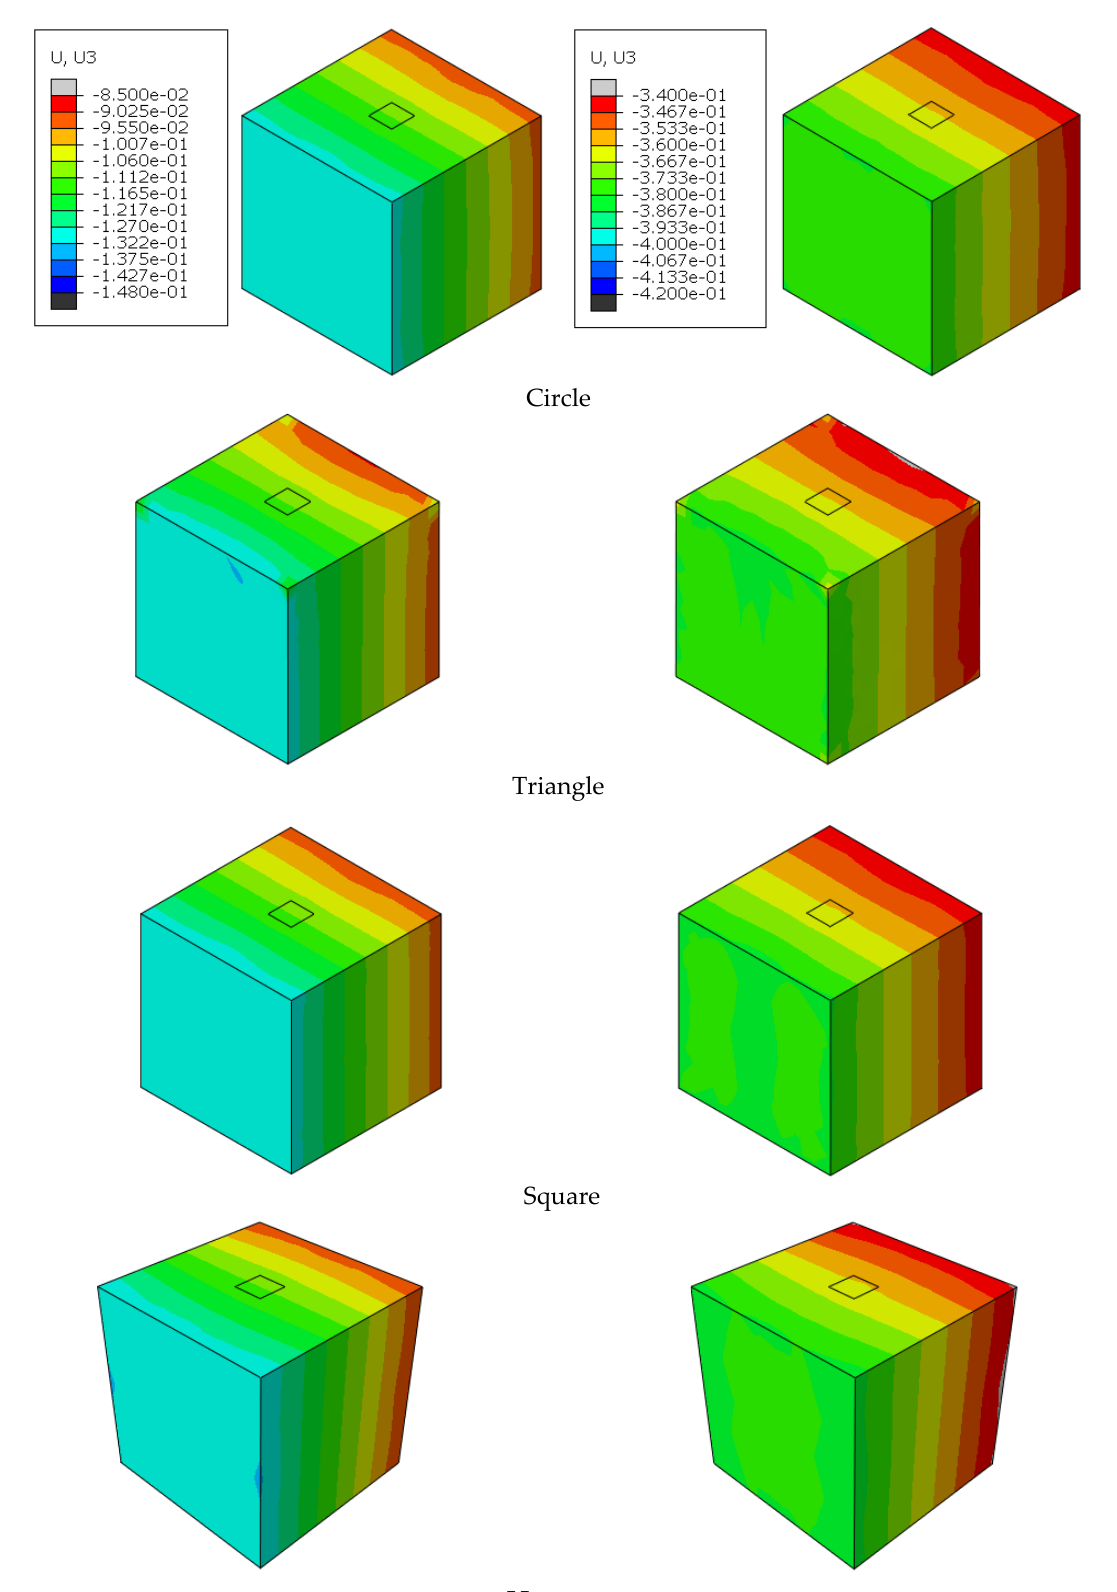
Figure 8. State of S33 stresses at two increments of time. ( a ) t = 0.6 ms and ( b ) t = 0.7 ms.